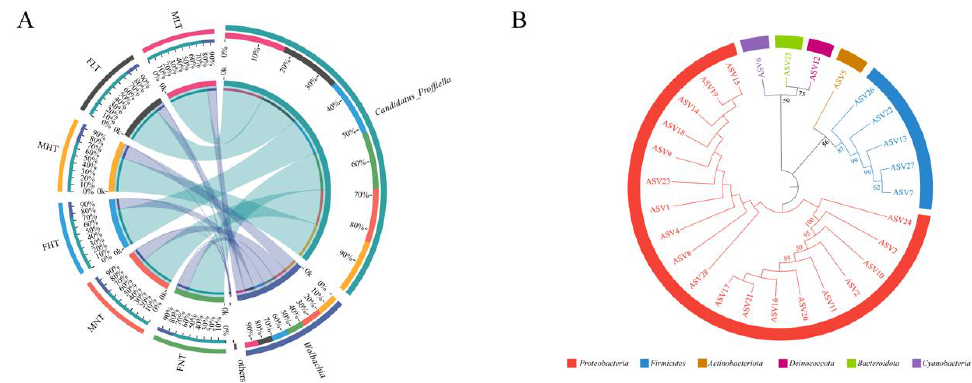
Figure 2. Impact of different temperature treatments of D . citri on the compositions of bacterial communities. ( A ) Chord diagram of relative abundance classified at the genus taxonomic level. ( B ) Phylogenetic analysis of the bacterial community identified in D. citri based on amplicon sequence variant (ASV) sequences. A tree was constructed using the neighbor– joining method via MEGA 5.05. Bootstrap support values for 1000 samples were provided on the branches (only showing values above 50%). The ASV sequences used for constructing the phylogenetic tree are listed in Table S2. FNT and MNT: female and male under a normal – temperature treatment (26 °C); FHT and MHT: female and male under a high – temperature treatment (42 °C); FLT and MLT: female and male under a low-temperature treatment (15 °C). Every group had four biological replicates of D. citri .